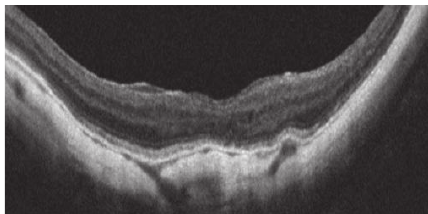
Figure 2: SD-OCT exhibits a flattened and reattached hole rim around the whole circumference of the previous macular